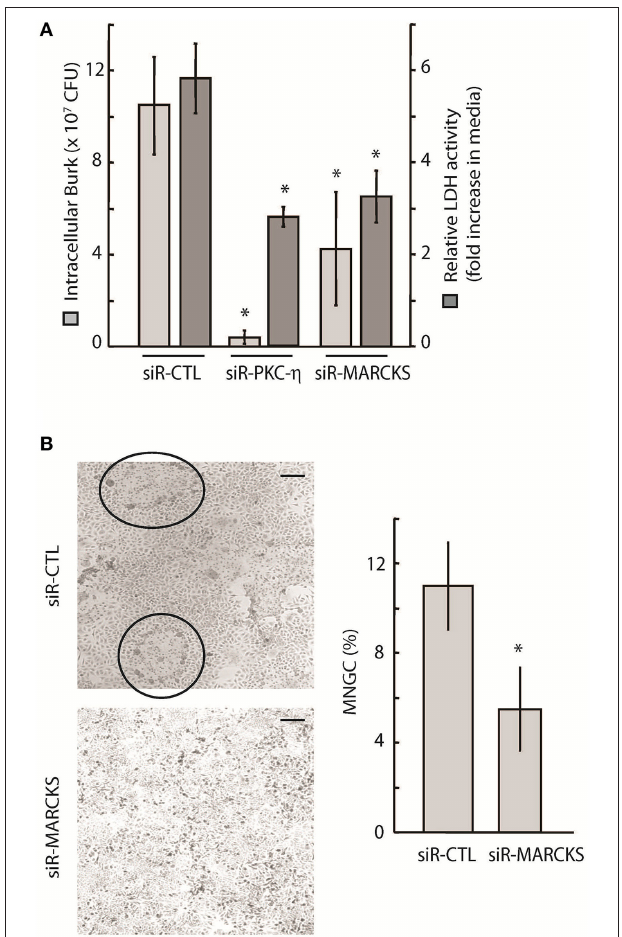
FIGURE 4 | Intracellular survival and spread of pathogenic Burkholderia is dependent on PKC- η and MARCKS function. (A) A549 cells were treated with 20 nM siRNA targeting MARCKS or PKC- η for 72 h prior to infection with Bt CDC2721121 at MOI 50. After 2 h of infection, cells were treated with 250 µ g/ml kanamycin for 3 h, and incubated overnight in antibiotic-free media. Cells were collected 24 h post-infection and lysed with 0.1% Triton to release the intracellular bacteria. Colony forming units (CFU) were calculated from limiting dilutions of the cell lysates incubated on nutrient agar for 24 h at 37 ◦ C. LDH activity was measured in conditioned media and is presented as fold increase in the 24 vs. 2 h post infection. The average and standard deviation from three independent experiments are shown. The “*” denotes statistical significance ( p < 0.05) for CFU counts and relative LDH activity in samples treated with siRNA to MARCKS or PKC- η , compared to control samples (siR-CTL). (B) A549 cells were treated with 20 nM siRNA against MARCKS or with non-targeting (siR-CTL) siRNA 72 h prior to infection with Bt CDC2721121 at MOI 50. Cells were fixed 18 h post-infection, stained with Giemsa, and the percentage of MNGC formation was calculated relative to normal cells per field of view. The average and standard deviations were derived from at least 10 fields of view covering an entire 20 mm culture dish. The “*” denotes statistical significance ( p < 0.05) for % MNGC in samples treated with siRNA to MARCKS compared to samples treated with control siRNA (siR-CTL). The scale bar is 60 µ M in